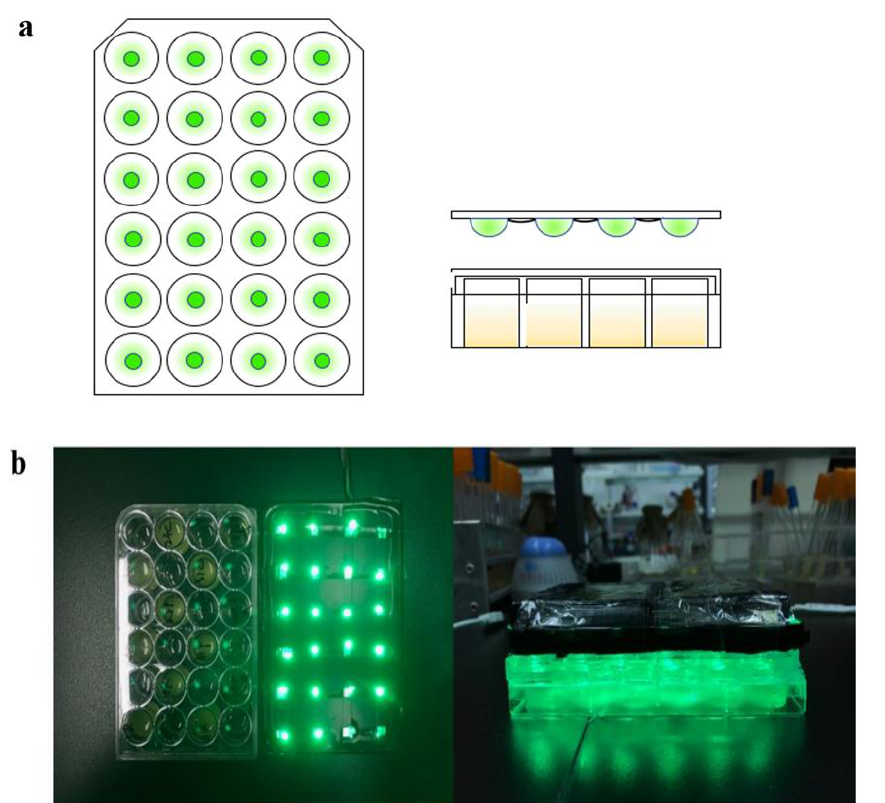
Figure 2. Diagram of the light-emitting diode array of the 24-well plate (LA-WP). ( a ) Design of the LA-WP. Twenty-four SMD LEDs were installed and used to irradiate each well of the 24-well plate separately and independently. ( b ) Photos of the light device.